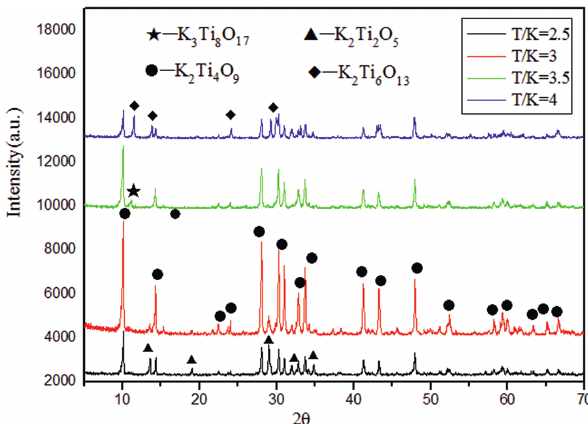
Figure 3: XRD patterns of samples with different T/K ratios calcined at